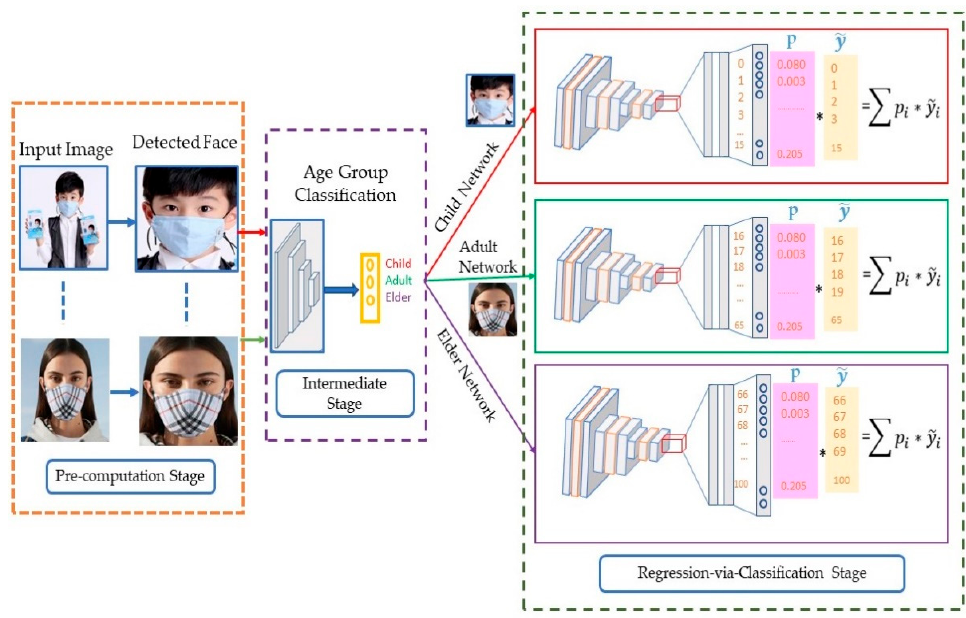
Figure 2. Schematic diagram of the proposed masked face real age estimation method.